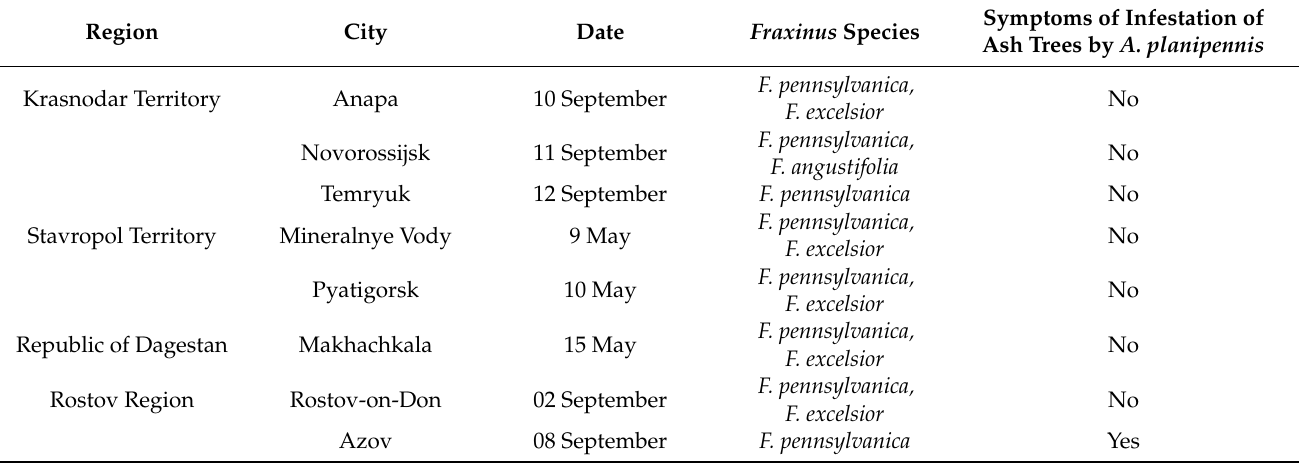
Table 1. Results of surveys of ash trees ( Fraxinus spp.) in